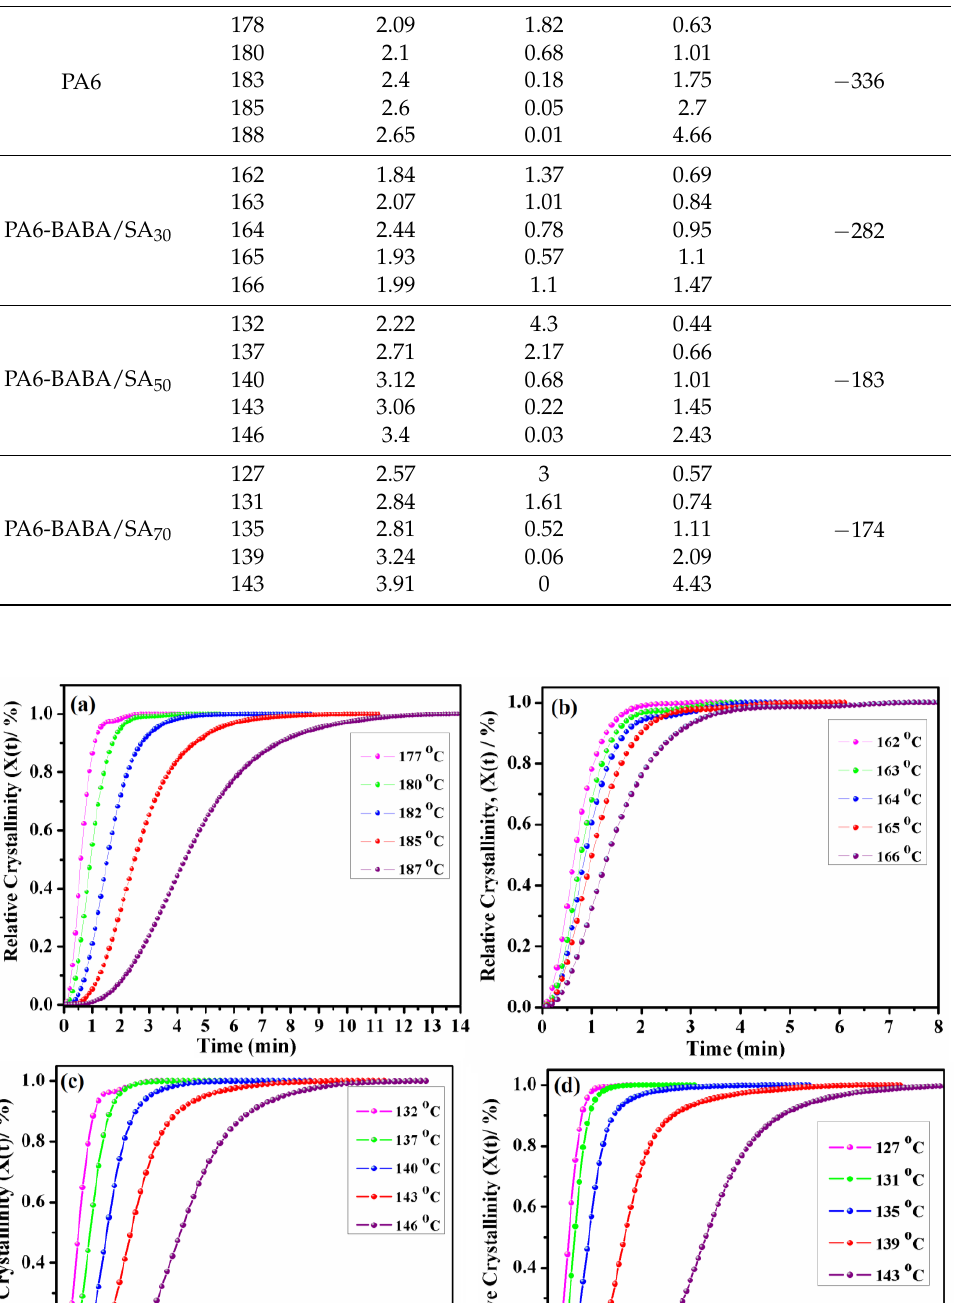
Table 4. Kinetic parameters of isothermal crystallization of virgin PA6 and PA6-BABA/SA copolyamides at various predetermined temperatures. Table 3. Isothermal crystallization kinetic temperatures ( T ) and crystallization times (min) for neat PA6 and PA6-BABA/SA.